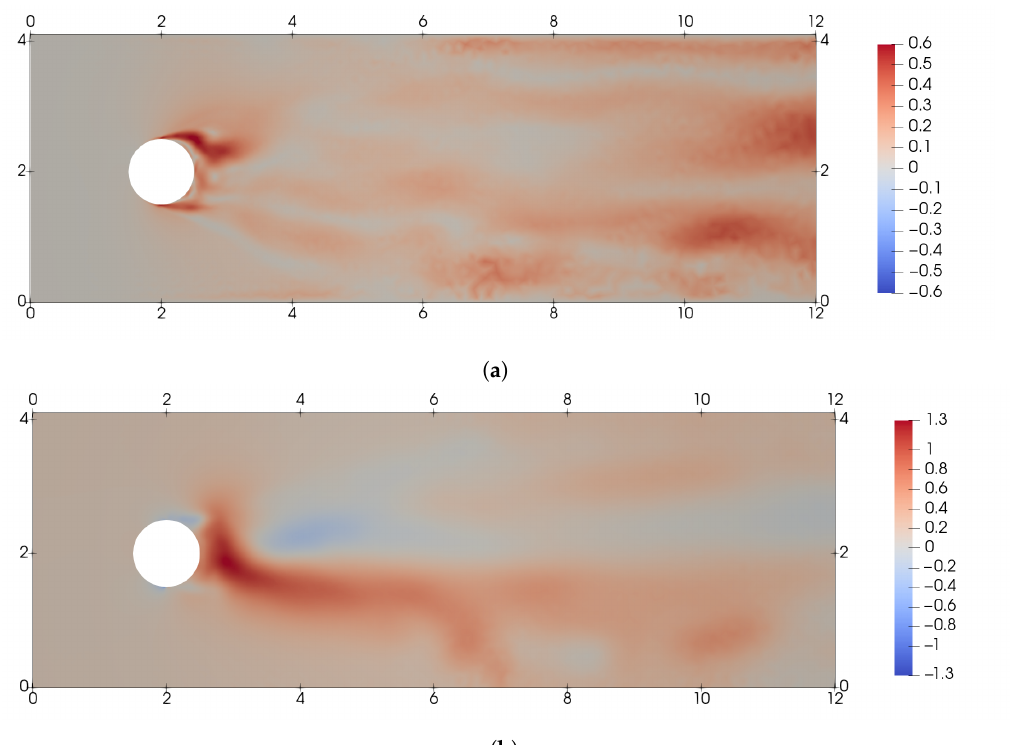
Figure 15. Difference in the mean flow fields at Re = 2000, between the controlled and baseline case. ( a ) Difference in the mean magnitude of velocity fields. ( b ) Difference in mean pressure